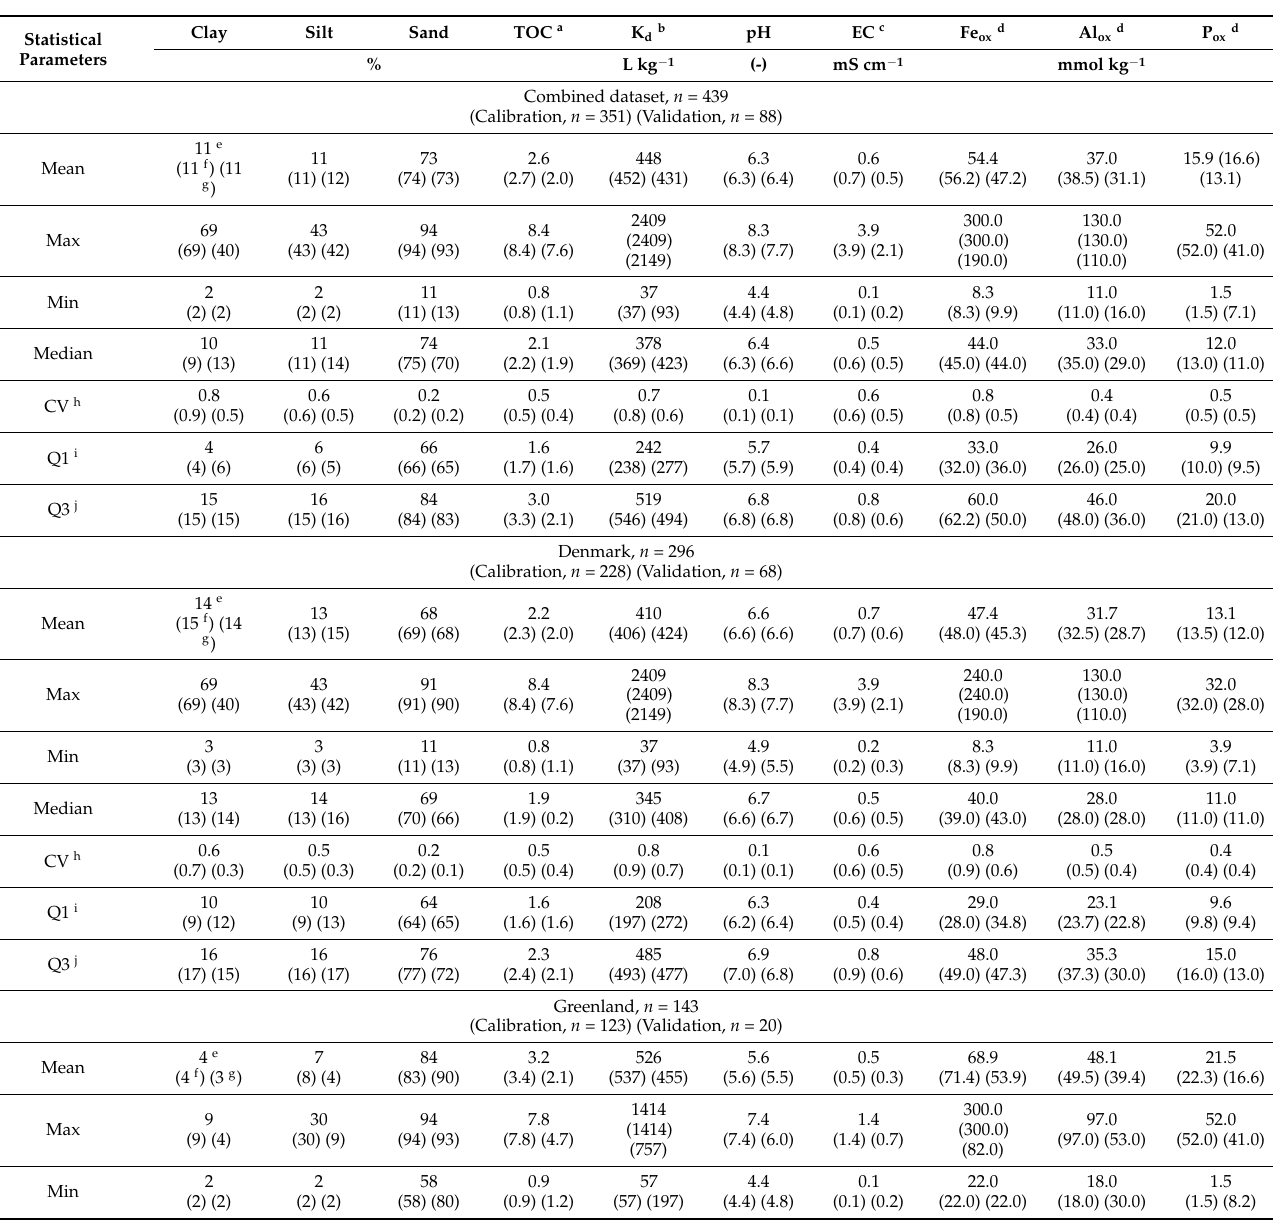
Table 1. Descriptive statistics of soil properties for all datasets, including their respective calibration and validation